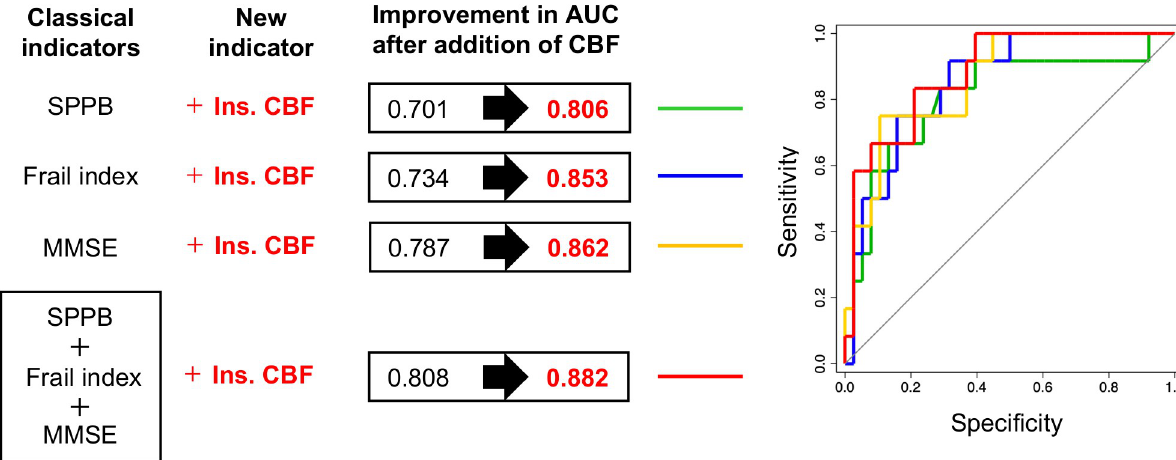
Fig 3. Results of multivariable logistic regression analyses with an addition of CBF in the insula to classical indicators. Abbreviations: AUC, area under curve; CBF, cerebral blood flow; Ins, insular; MMSE, mini mental state examination; SPPB, short physical performance battery.